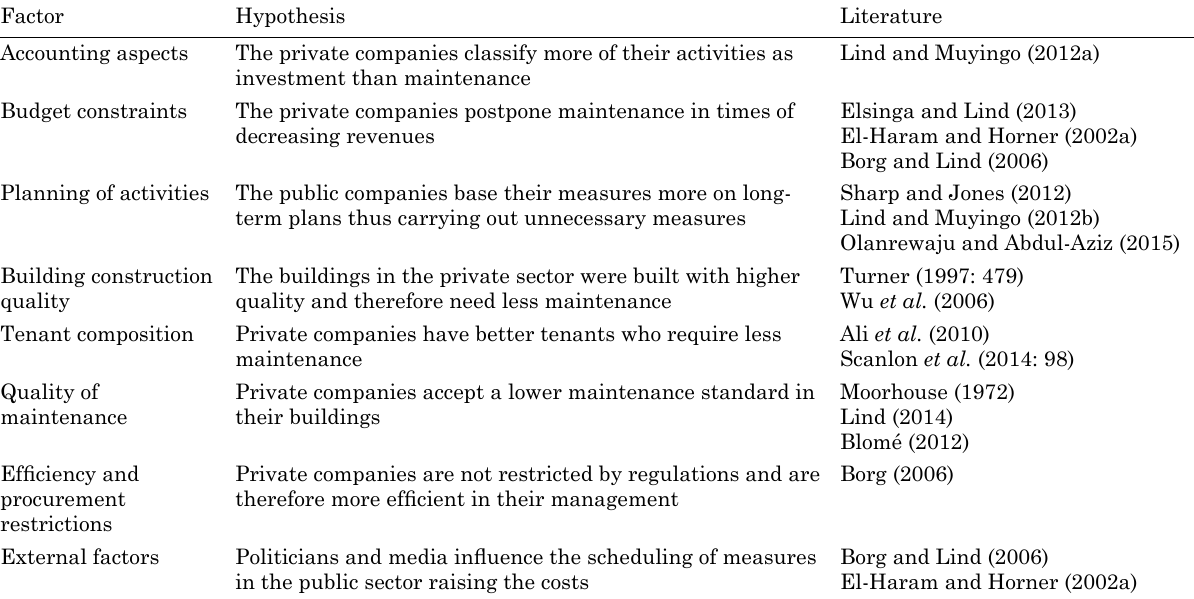
Table 4. The hypotheses behind the questionnaire